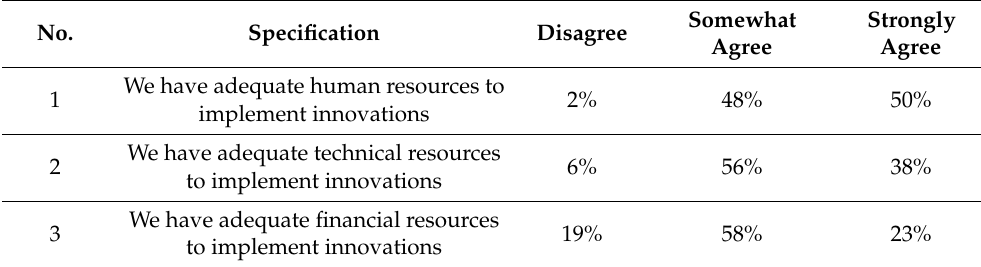
Table 2. The innovative resources